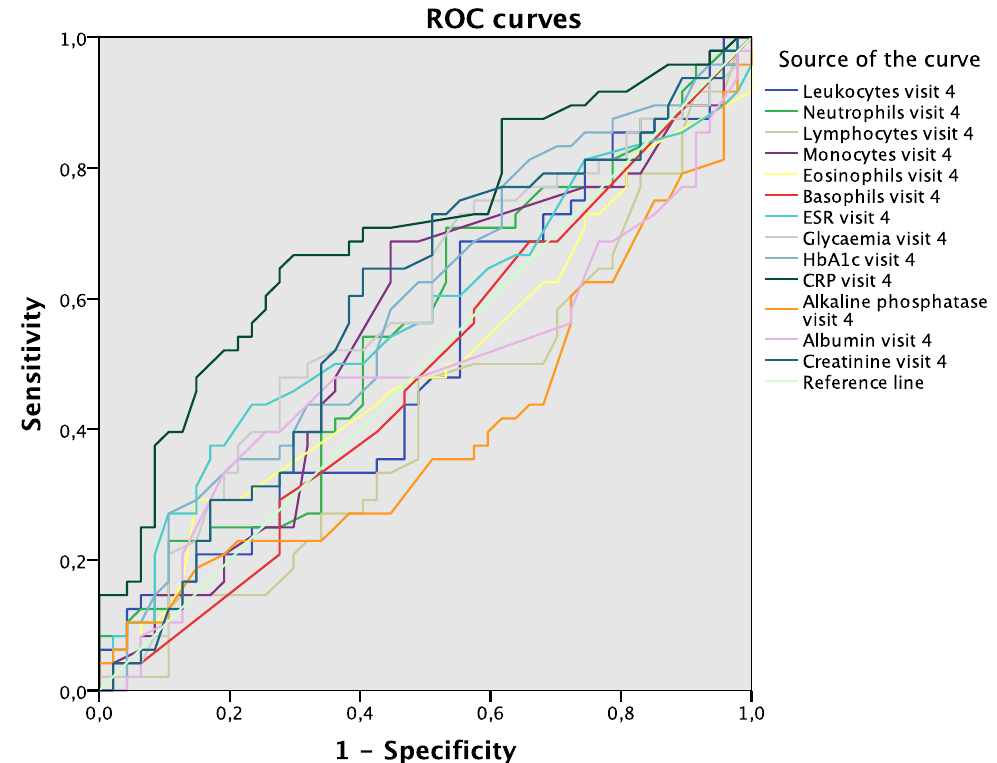
Figure 5. ROC curves. Blood parameters in visit 4 associated with complications in visit 4. Abbreviations: ROC, receiver operating curve; ESR, erythrocyte sedimentation rate; HbA1c, glycosylated hemoglobin; CRP, C-reactive protein.